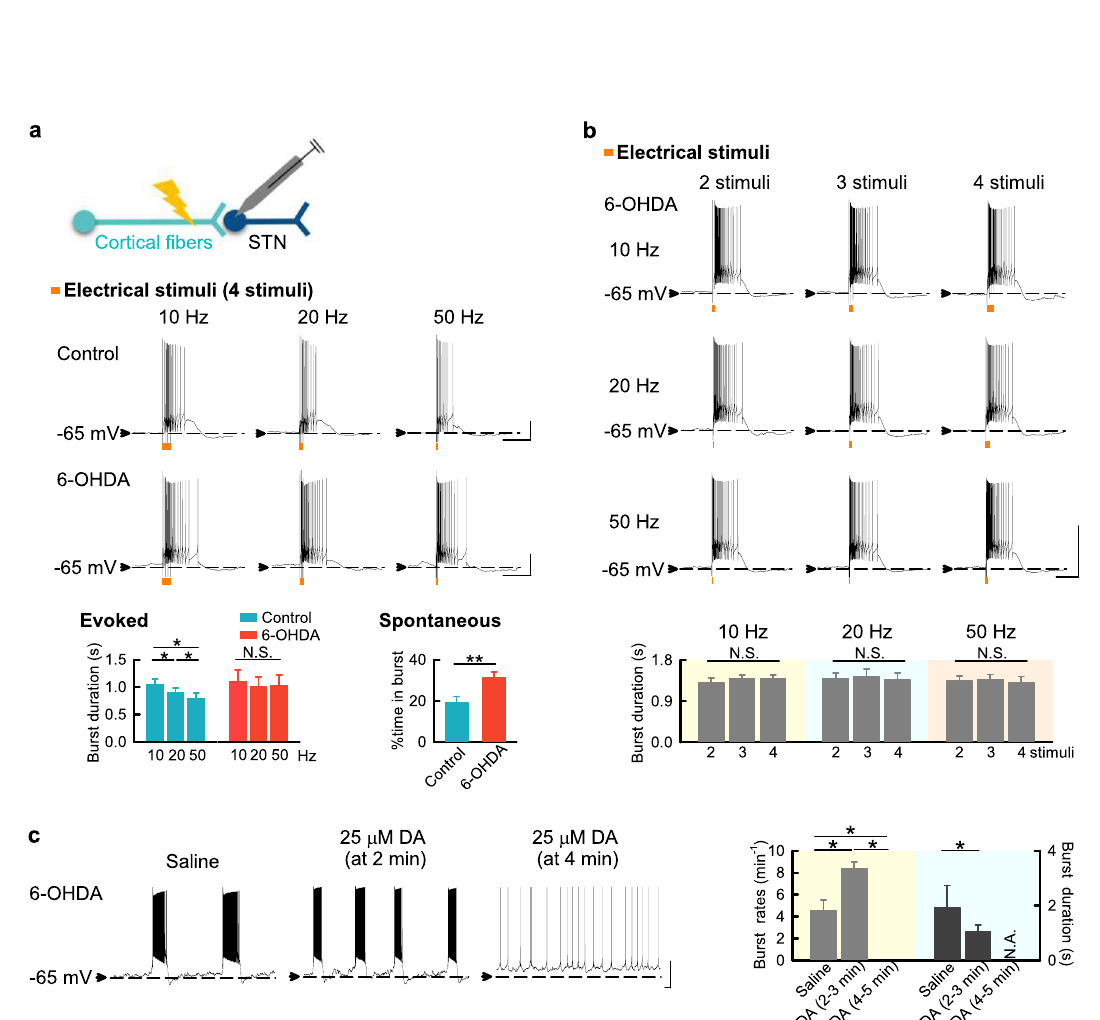
Fig. 6 Less spatiotemporal changes in MC discharges from rest to movement in parkinsonian rats. a A diagram for the SPIKE-distance, a time-dependent dissimilarity score (S), in 2 simulate spike trains. The waveform denotes temporal pro fi le of S (S(t)), and the dotted line denotes the time average of S. S(t) for 7 spike trains is calculated by averaging all pairwise S(t) (see “ Method ” , and also refer to Kreuz et al. 112 ). b , c Sample raster plots of multi-unit spikes in MC and concomitant dissimilarity score (S), from a segment at rest (left) and the other one during movement (right) in a control rat ( b ) and a parkinsonian rat (6-OHDA, c ). Note the apparently larger temporal changes in S during movement than at rest in control but not in parkinsonian rats. d The average power-frequency spectra of the whole temporal pro fi le of S (S(t)) in all segments. n = 27 at rest and n = 23 during movement in control, and n = 35 at rest and n = 37 during movement in parkinsonian rats, from 10 control and 11 parkinsonian rats, respectively. Note the markedly enhanced peak at ~0.5 Hz from rest to movement in control but not in parkinsonian rats. e The time average of the dissimilarity score (S) of the 10-s segments in MC (left panel), and the total powers (0 – 250 Hz) of the spectral analyses from segments in part d (right panel). f – i Similar analyses to ( b – e ) were done on STN. n = 33 at rest and n = 34 during movement in control, and n = 22 at rest and n = 21 during movement in parkinsonian rats, from 10 normal and 11 parkinsonian rats, respectively ( h , i ). PSD spectra were presented as mean (solid curves) ± standard deviation (shaded areas). Data in the bar plot were presented as mean ± S.E.M. Data in ( e ) and ( i ) were analyzed with 2 × 2 independent model ANOVA and simple main effect tests for pairwise comparison. Each horizontal line reports the simple main effect, and each square bracket reports the main effect of control vs. 6-OHDA in ANOVA. * p < 0.05, ** p < 0.01, N.S., nonsigni fi cant.